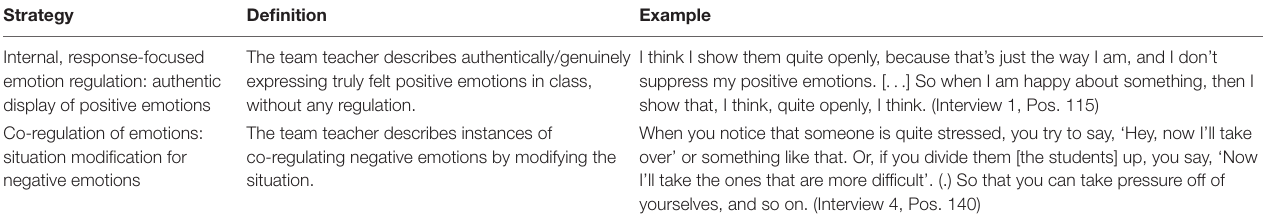
TABLE 1 | Examples from the coding scheme.